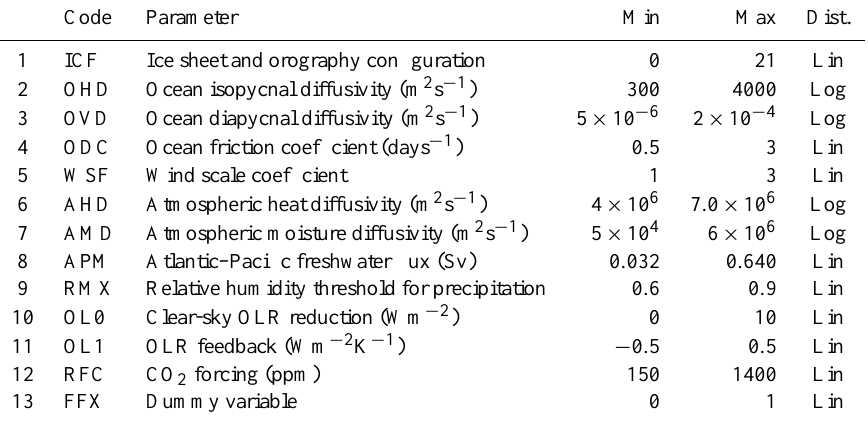
Table 1. Ten of the chosen parameters, with the exception of ICF and RFC, are taken from an ensemble design used in Holden et al. (2010). The ranges were initially based on those used in the same study. However, adjustments are needed since the model is run at 64 × 32 horizontal resolution here compared to the previously used 36 × 36 mesh. The ranges shown below are obtained after an initial exploratory ensemble. The distribution specifies whether their values (Lin) or the log of their values to base 10 (Log) are used to generate the sampling plan in Sect.